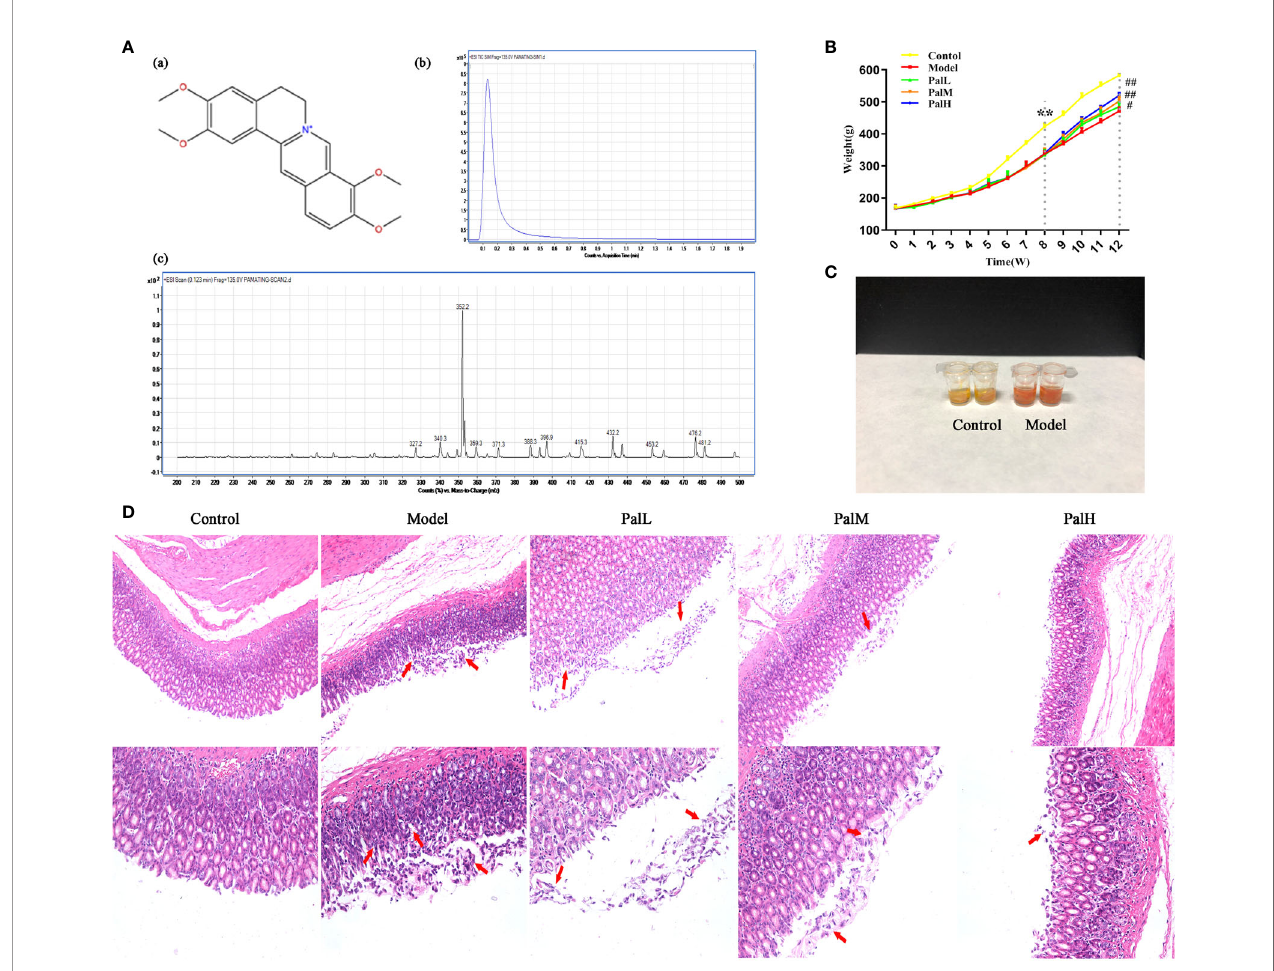
FIGURE 2 | Pal attenuated pathological damage and in fl ammation in H. pylori – induced chronic atrophic gastritis (CAG). (A) Chemical structure (a), TIC (b) and Scan (c) chromatogram of Pal. (B) Weight of SD rats (n=6). (C) Rapid urease test of stomach tissues. (D) Morphology and hematoxylin and eosin (H & E) staining of rats stomach (200 × and 400 × magni fi cation). ** P < 0.01 vs control group. # P < 0.05 and ## P < 0.01 vs model group. PalL (10 mg/kg); PalM: (20 mg/kg); PalH: (40